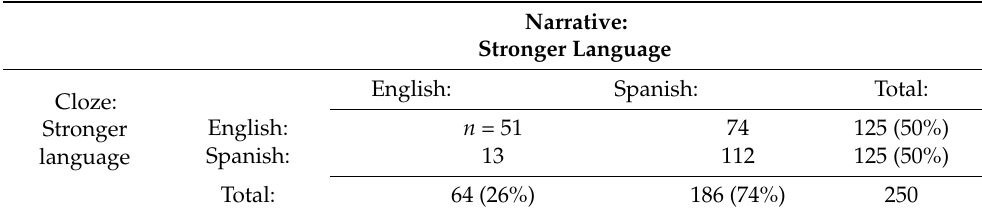
Table 6. Cross-tabulation of “stronger language” frequency counts across morphosyntax tasks.